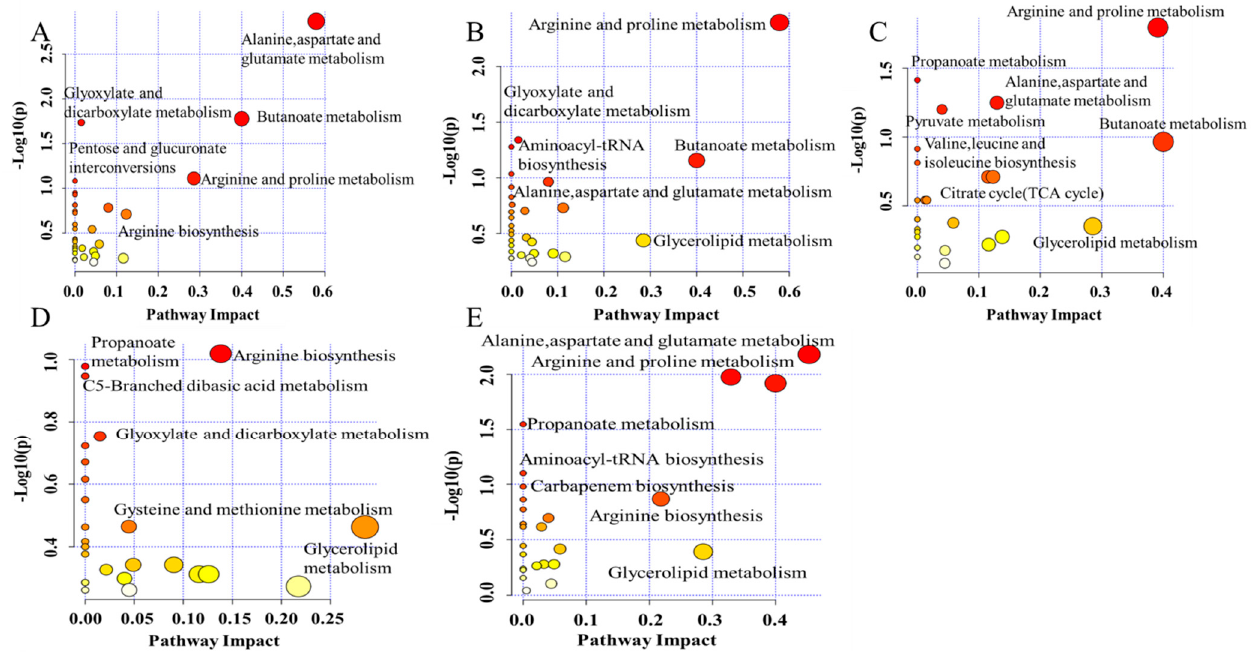
Figure 7. Changes in metabolic and biosynthetic pathways during fermentation with the treatment of F ( A ), H ( B ), T ( C ), D ( D ), and P ( E ). Note: CK, blank control group; F, flutriafol; H, hexaconazole; T, tebuconazole; D, difenoconazole; P, propiconazole.